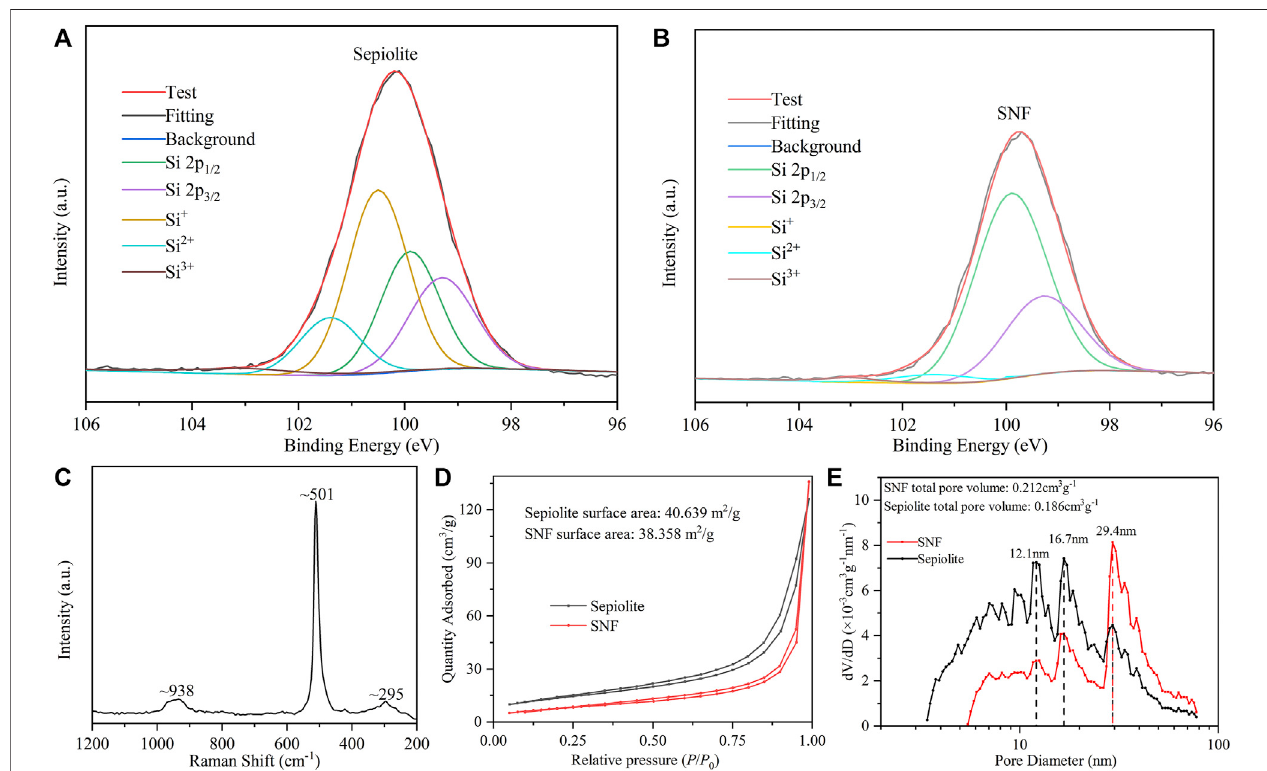
FIGURE 5 | High-resolution Si 2p XPS spectrum of (A) natural sepiolite and (B) SNF. (C) Raman spectra of SNF. (D) N 2 adsorption – desorption isotherm and (E) pore size distribution curve of natural sepiolite and SNF.